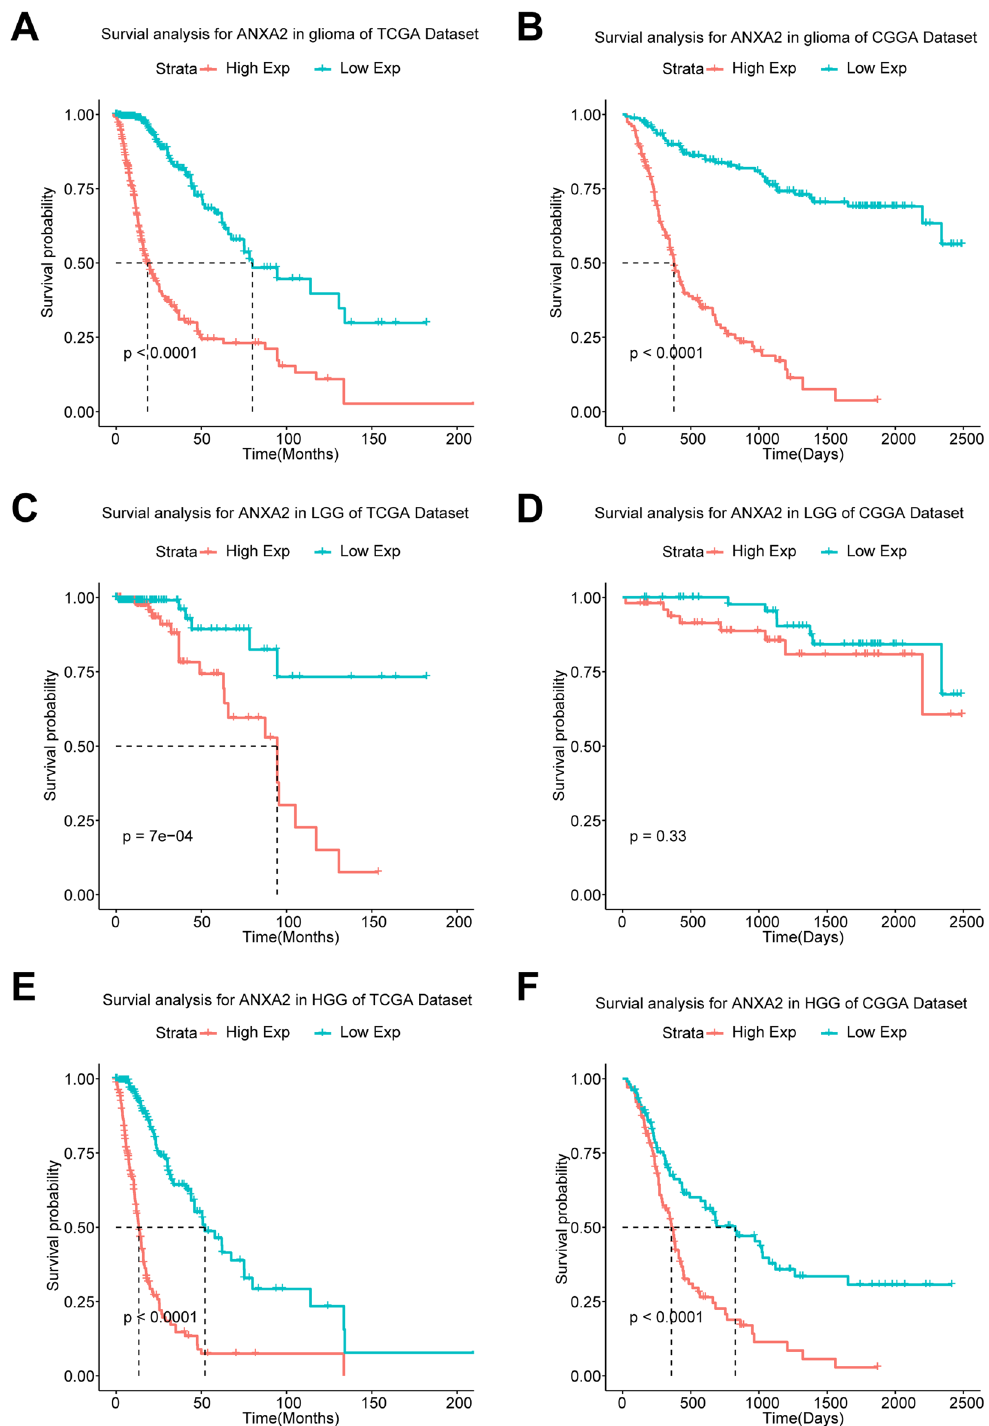
Figure 2. Survival analysis of glioma patients based on ANXA2 expression in TCGA and CGGA cohorts. Kaplan–Meier analysis indicated that high expression of ANXA2 was related to significantly worse prognosis overall in glioma ( A,B ), LGG ( C,D ) and HGG ( E,F )